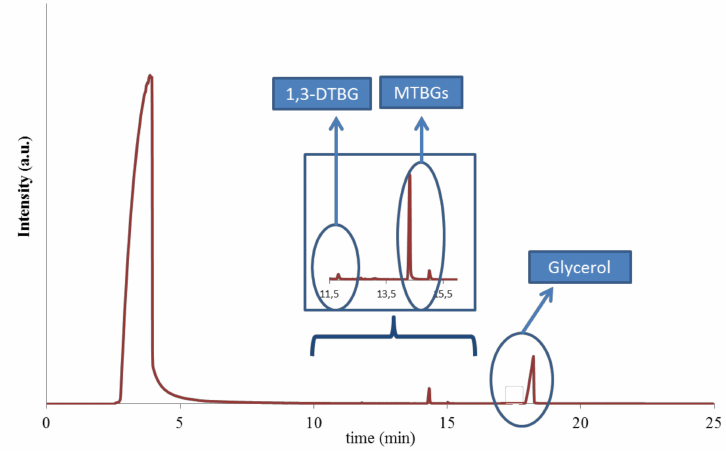
Figure 11. Chromatogram of the organic fraction absorbed in the